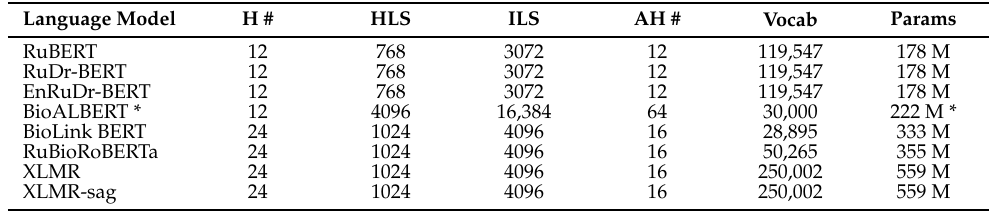
Table 6. Layer sizes and number of parameters of language models used. H # denotes a number of the hidden layers, HLS—a hidden layer size, ILS—an intermediate layer size between transformer blocks, AH #—a number of attention heads in the transformer block, vocab—the size of the language model vocabulary, params—an approximate number of parameters (weights) of the model with unique values. *—BioALBERT has a lower number of parameters because hidden layers share the same weights in ALBERT architecture. However, there are more neurons, therefore, more weights (just with the same